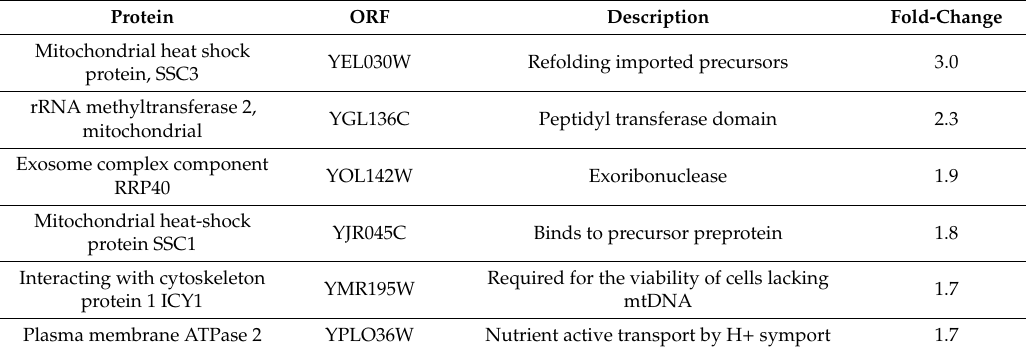
Table 3. Summary of soluble proteins that are significantly ( p < 0.05) overrepresented in sua5 relative to WT and map to enriched GO